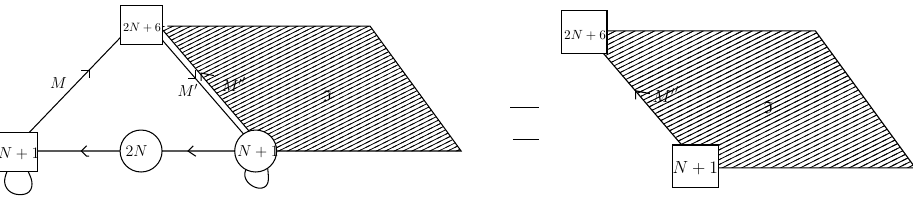
Figure 10. S gluing with USp